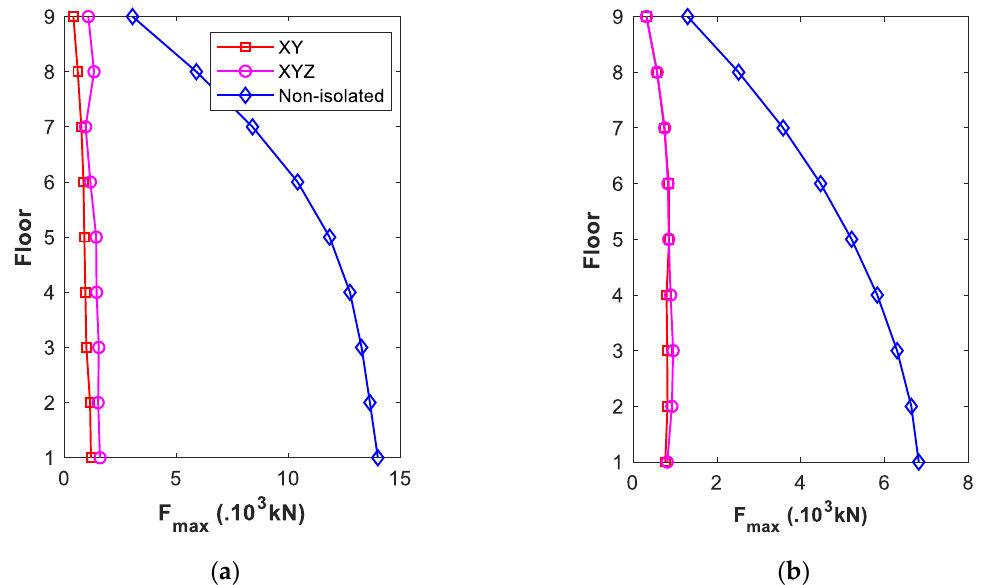
Figure 11. Peak shear force on each floor under bi- and tri-directional and fixed-base cases: ( a ) the near-source record and ( b ) the far-field record.